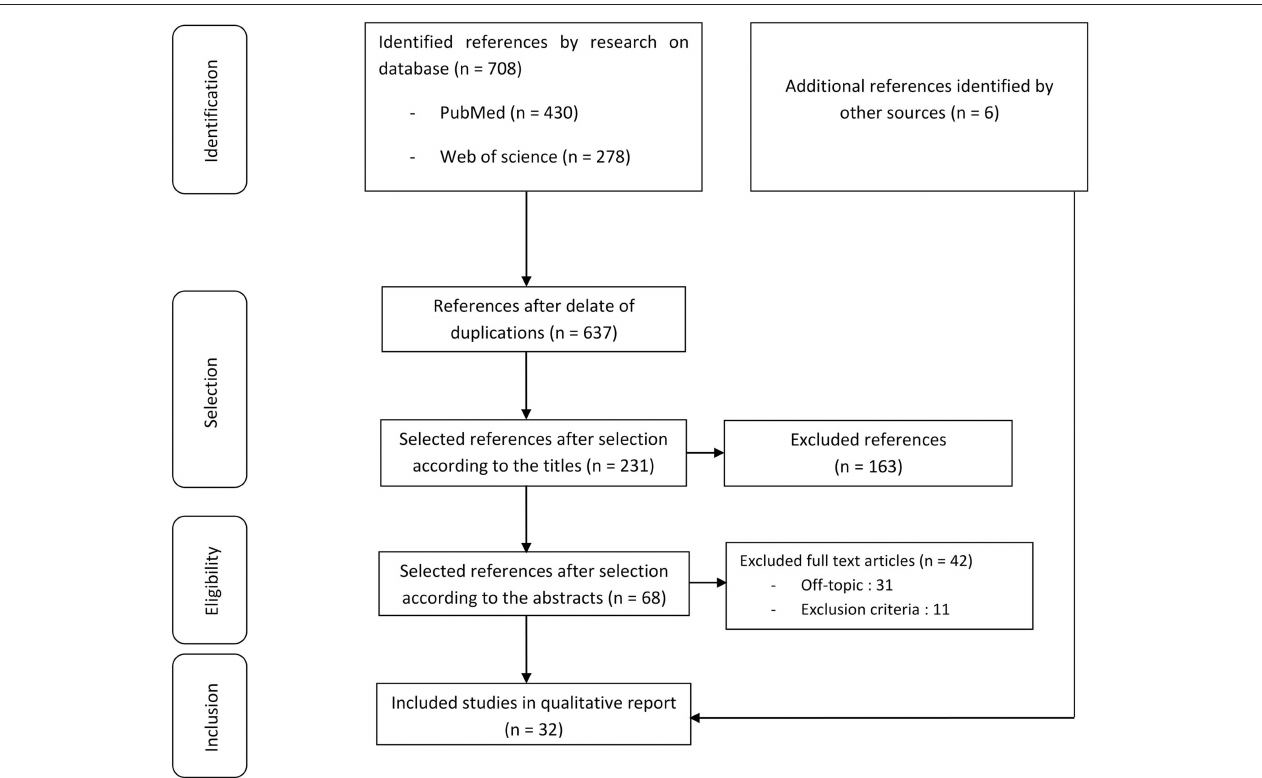
FIGURE 1 | Preferred Reporting Items for Systematic Reviews and Meta-Analyses (PRISMA) flowchart for the study selection.